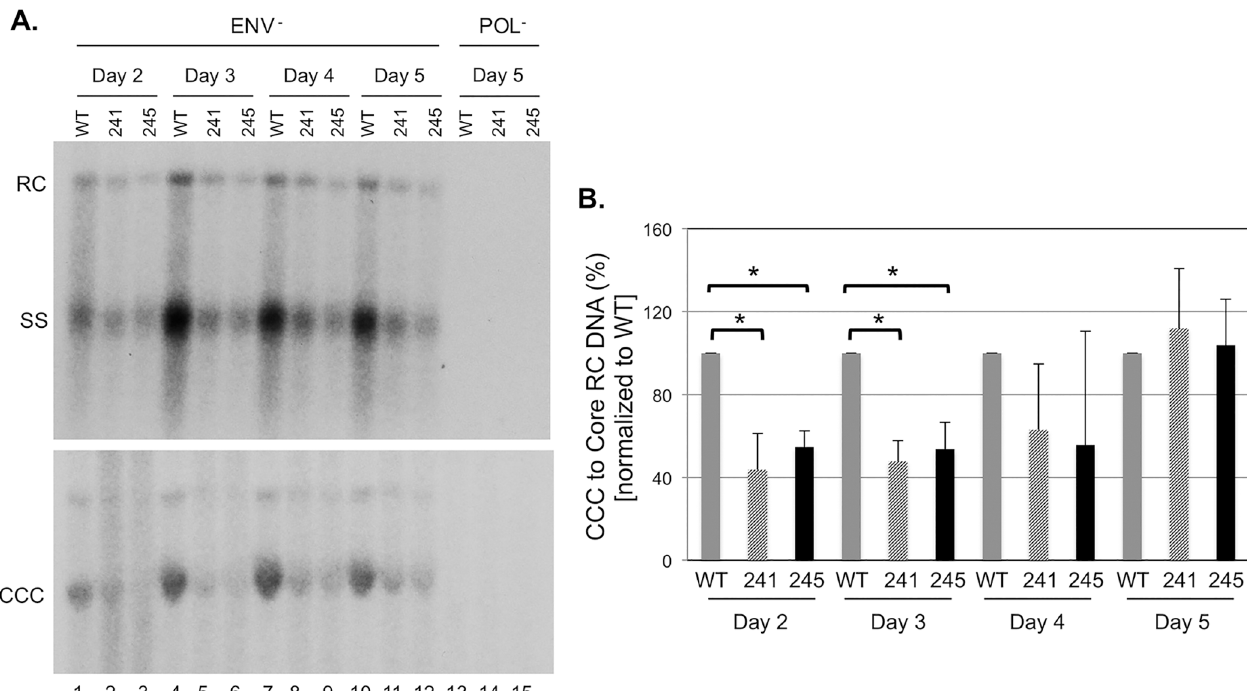
Fig 5. Tdp2 knockout modestly suppressed DHBV CCC DNA formation in HepG2 cells. HepG2 cells, with (241, lanes 2, 5, 8, 11, 14; 245, lanes 3, 6, 9, 12, 15) or without (WT, lanes 1, 4, 7, 10, 13) Tdp2 knockout, were transfected with the envelope-defective DHBV replication plasmid (lanes 1 – 12), or the polymerase-defective DHBV plasmid as a negative control (lanes 13 – 15). On the indicated days post-transfection the cells were harvested and analyzed for protein expression and viral DNA levels. A. DHBV core (top) and PF DNA (bottom) levels analyzed by Southern blot analysis. B. Levels of DHBV CCC DNA on the indicated days post-transfection were normalized to those of the core RC DNA and the ratios of CCC/core RC DNA in the Tdp2 KO cells were compared to those in the WT cells, which were set at 100. The asterisks ( * ) in B indicate statistically significant differences (P < 0.05; unpaired, two-tailed t- test). CCC, CCC DNA; RC, RC DNA; SS, single-stranded DNA [full-length (-) strand].